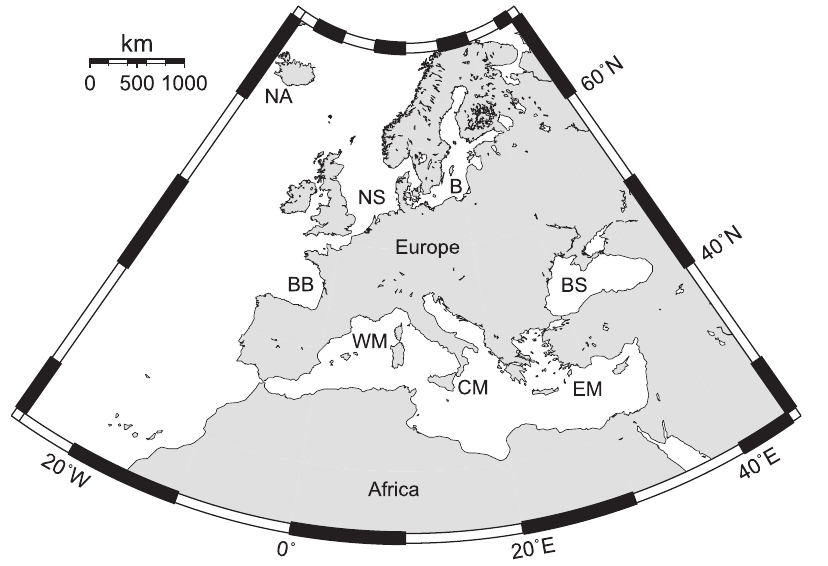
Figure 1. Map with sampling areas for fishes from European seas. Northeastern Atlantic (NA), North Sea (NS), Baltic (B), Bay of Biscay (BB), Western Mediterranean (WM), Central Mediterranean (CM), Eastern Mediterranean (EM), and Black Sea (BS).